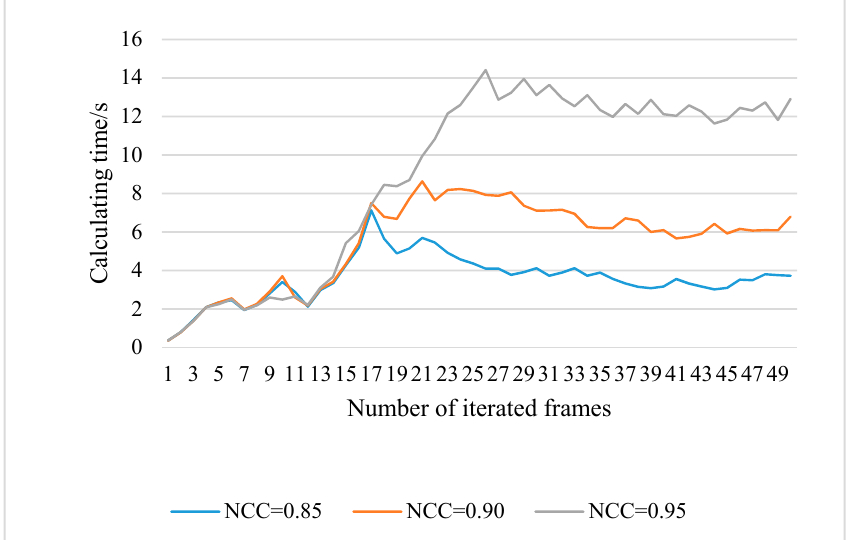
Figure 17. The number of iterated keyframes versus the number of pixels per iteration.